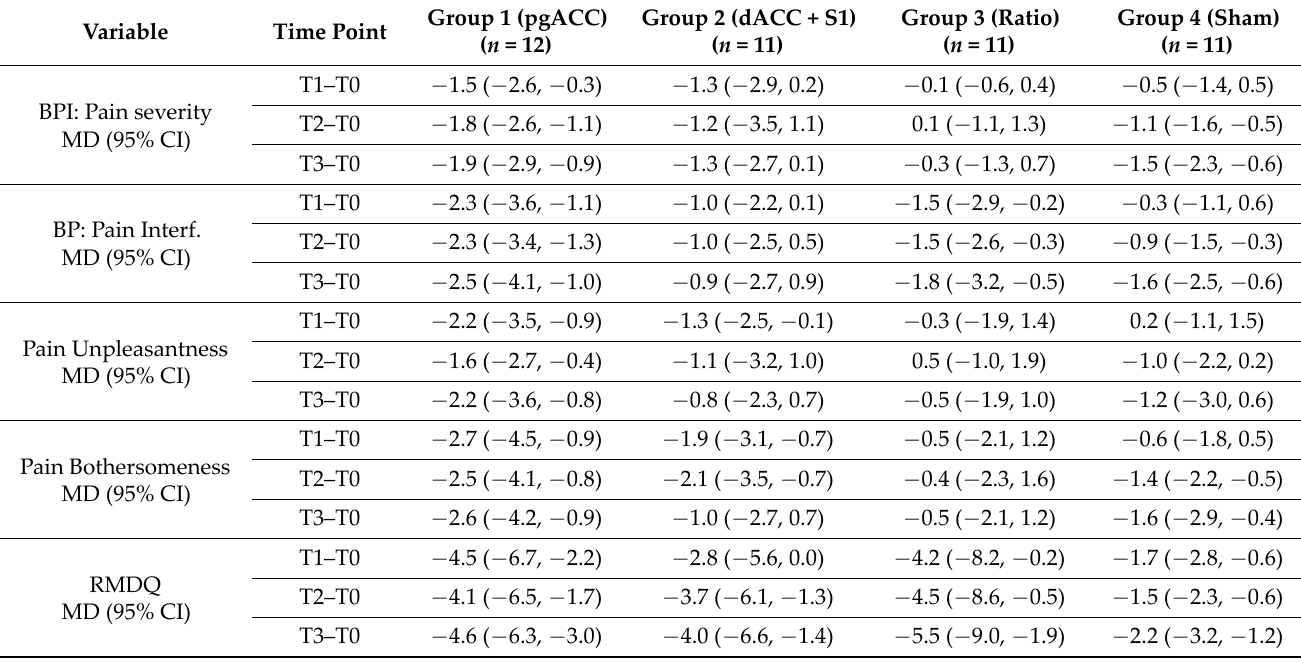
Table 3. Descriptive data for the clinical measures at all timepoints.